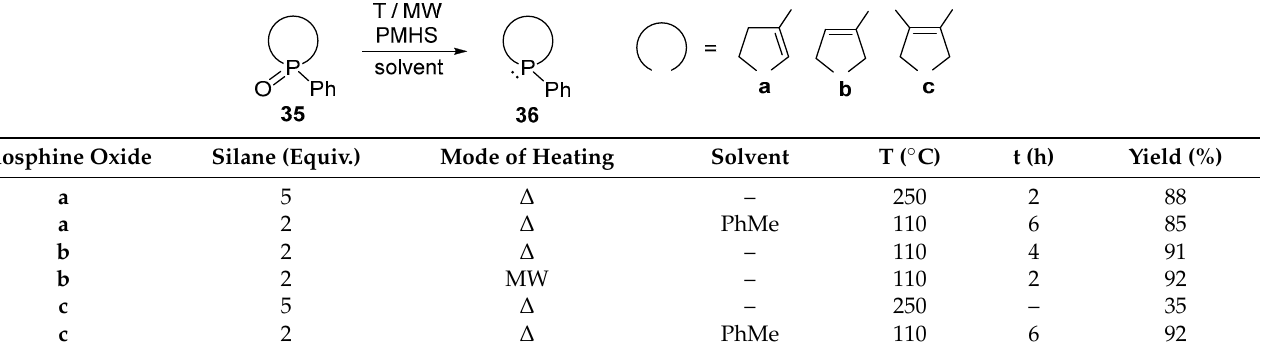
Table 14. The deoxygenation of a series of phospholene oxides using PMHS.